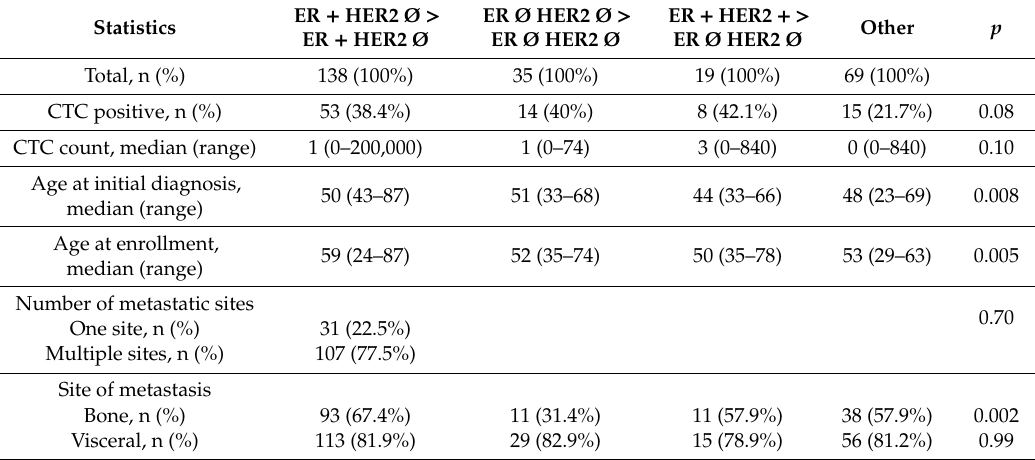
Figure 2. PFS and OS comparison between seven subgroups based on specific receptor change or stable patterns between PTs and MTs. Ø—negative; ER—estrogen receptor; HER2—human epidermal growth factor receptor 2. Table 3. Comparisons of demographic and clinical characteristics as well as CTC status, CTC count, and PFS and OS between 4 subgroups corresponding to therapeutically relevant receptor